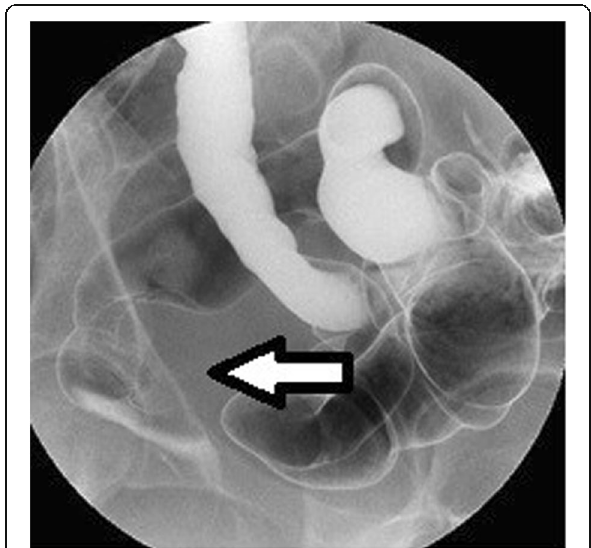
Fig. 3 A barium enema examination shows a 40-mm extramural mass in the